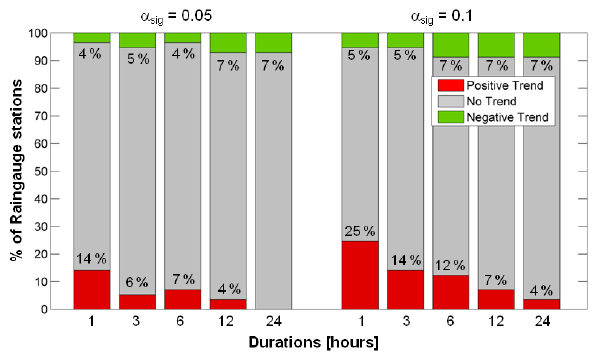
Figure 3. Percentage of raingauges showing a positive (red), negative (green) and a no trend 2 Fig. 3. Percentage of rain gauges showing a positive (red), negative (green) and a no trend (gray) in the annual maxima historical time (gray) in the annual maxima historical time series for 1, 3, 6, 12 and 24 hours, and for 3 series for 1, 3, 6, 12 and 24h, and for significance level α sig = 0 . 05 significance level  sig = 0.05 (left) and  sig = 0.1 (right). 4 (left) and α sig = 0 . 1